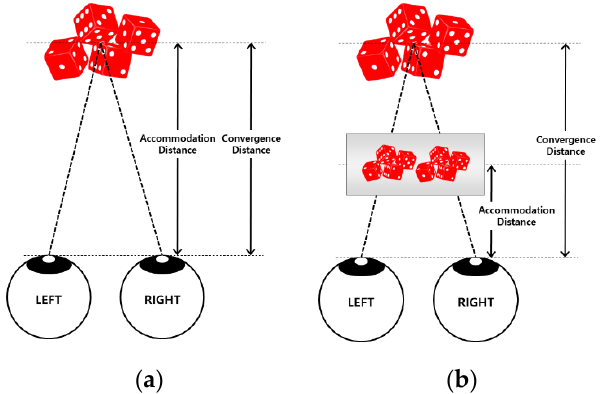
Figure 3. Accommodation and convergence distances: ( a ) agreement; ( b ) disagreement.